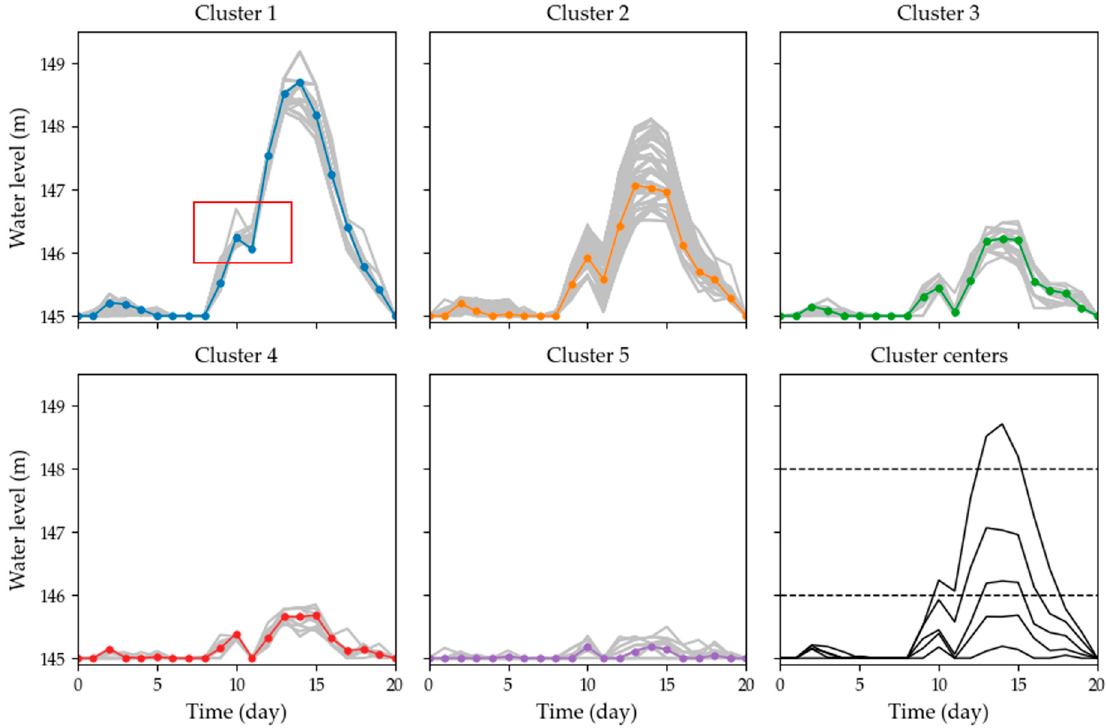
Figure 9. Clustering results on reservoir operation processes via Euclidean distance (ED). Clusters are drawn in each subfigure separately. The cluster centers are shown in the last subfigure.